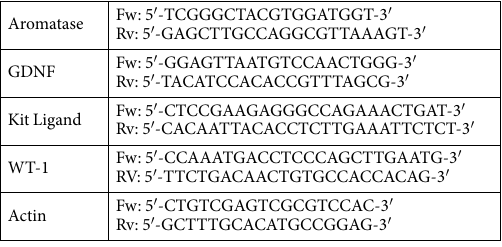
Table 1. List of